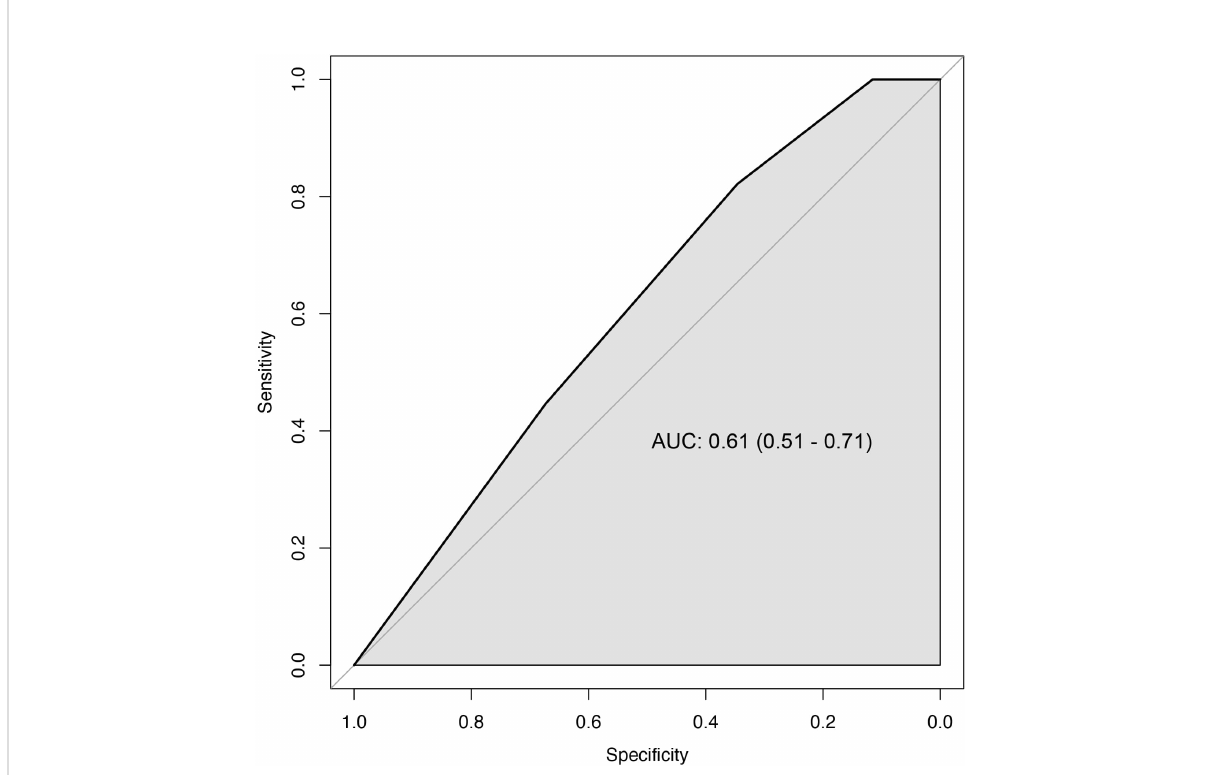
FIGURE 2 ROC curve of the MAC-scores ability to identify patients with high MIB-1 index (black line: AUC 0.61, 95% CI 0.51 – 0.71). The diagonal grey line indicates the model that has a completely random discrimination power.